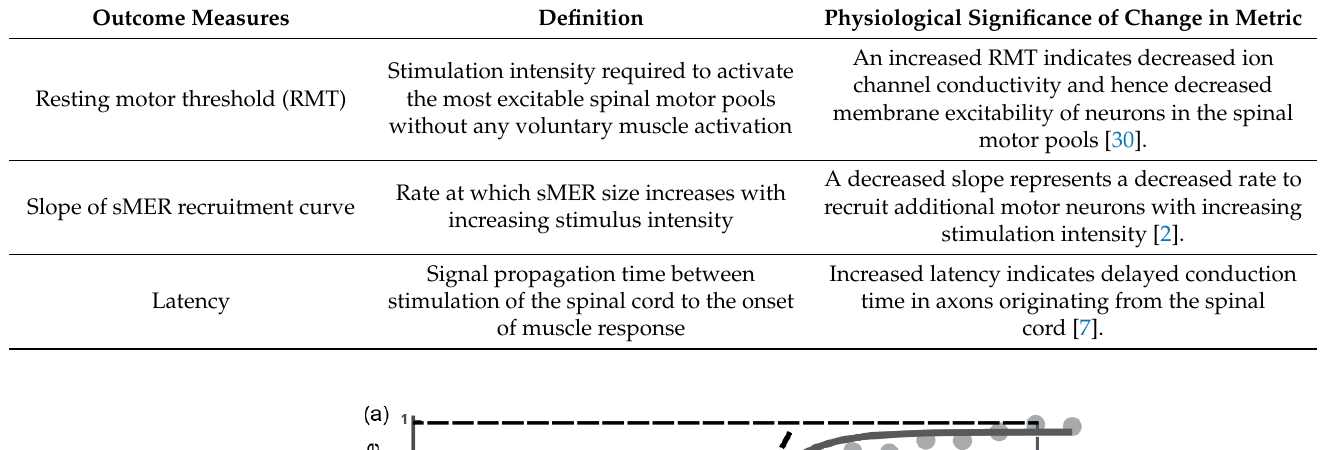
Table 1. Significance of outcome measures.